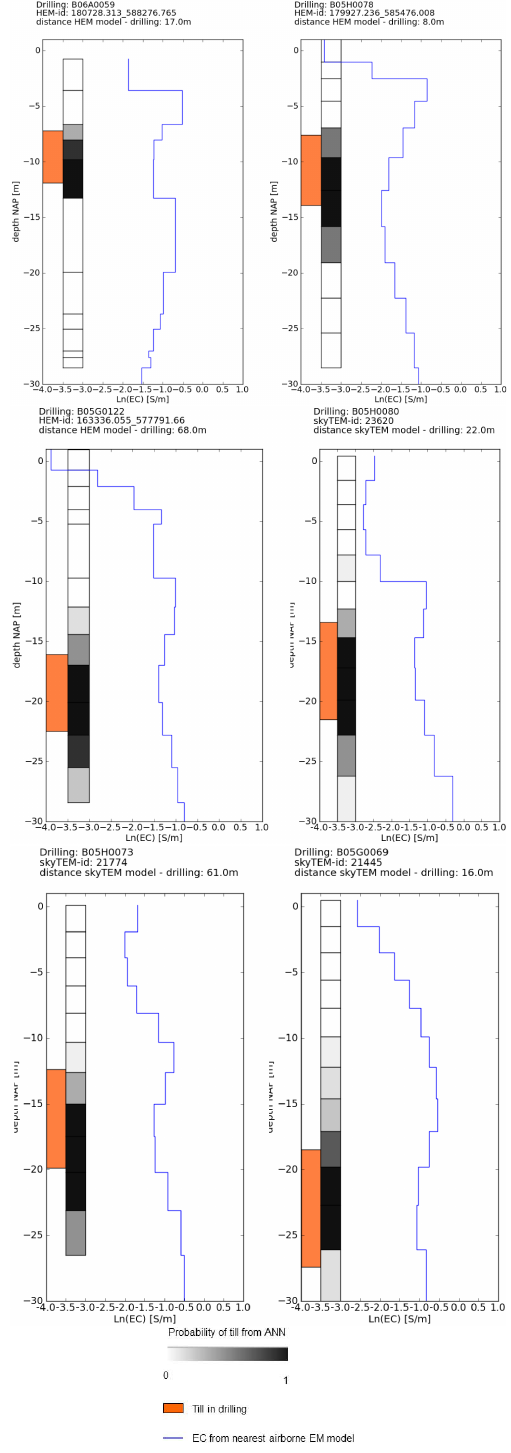
Fig. 15. Presence of till in drillings and probability of till from ANN for some selected EM models. Maximum distance between EM model and drilling is